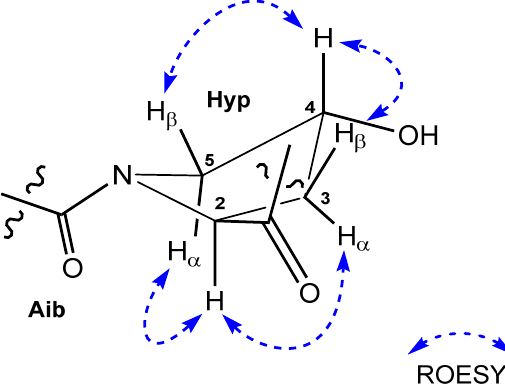
Figure 4. ROESY correlations of trans ‐ 4 ‐ OH ‐ proline.